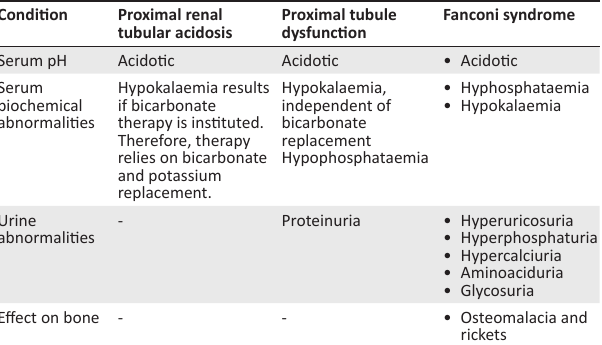
TABLE 3: Spectrum of tenofovir disoproxil fumarate-associated proximal tubular dysfunction. Condition Proximal renal tubular